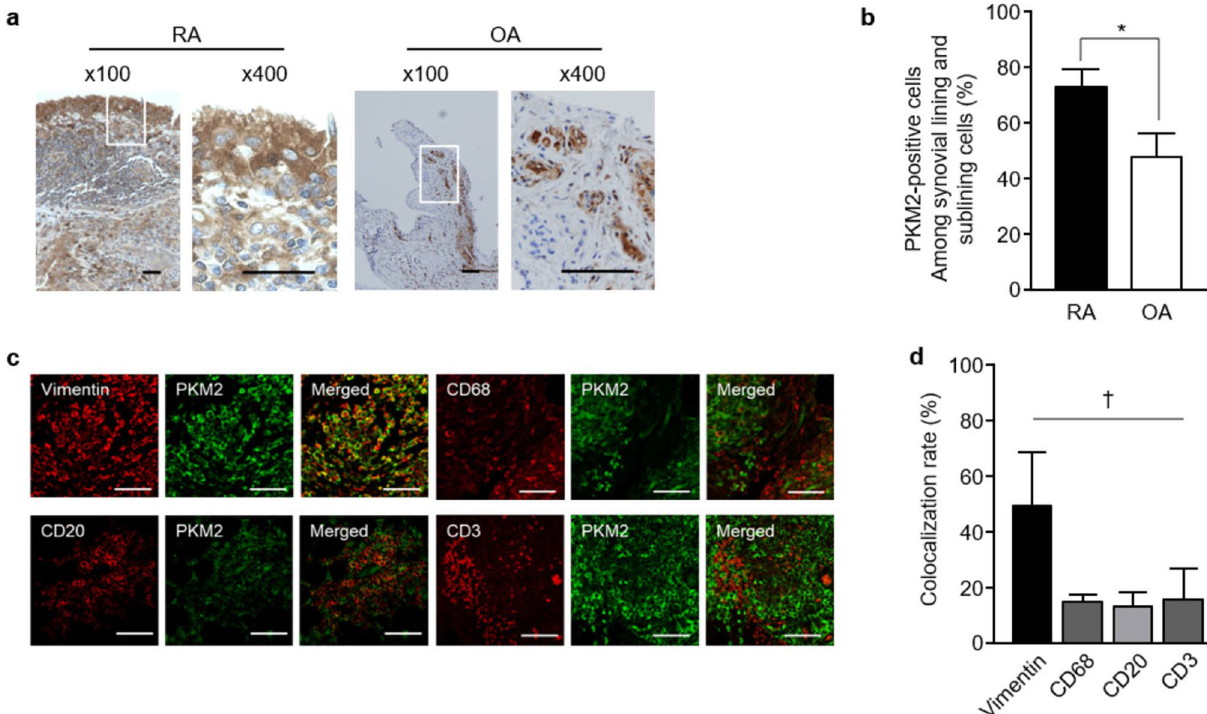
Figure 1. Intracellular PKM2 expression in RA synovial tissues. ( a ) In representative light microscopy photographs, PKM2 immunostaining was increased in RA synovial tissue. White boxes in the left figures (original magnification, × 100) indicate the magnified regions shown in the right figures (× 400). Scale bars = 200 μm. ( b ) The fraction of PKM2-positive cells was significantly higher among synovial lining and stromal cells in RA synovial tissues (n = 5) than in OA (n = 3) synovial tissues. *p = 3.06 × 10 –6 by the Mann– Whitney U test. ( c ) Representative confocal images showing PKM2 (green) expression in vimentin-positive, CD68-positive, CD20-positive, and CD3-positive cells (original magnification, × 400). Scale bars = 100 μm. ( d ) The colocalization rate between PKM2-positive and vimentin-positive cells was significantly higher than that of other cells (n = 4). † p = 0.03 by the Kruskal–Wallis test. Data with error bars were expressed as mean ±